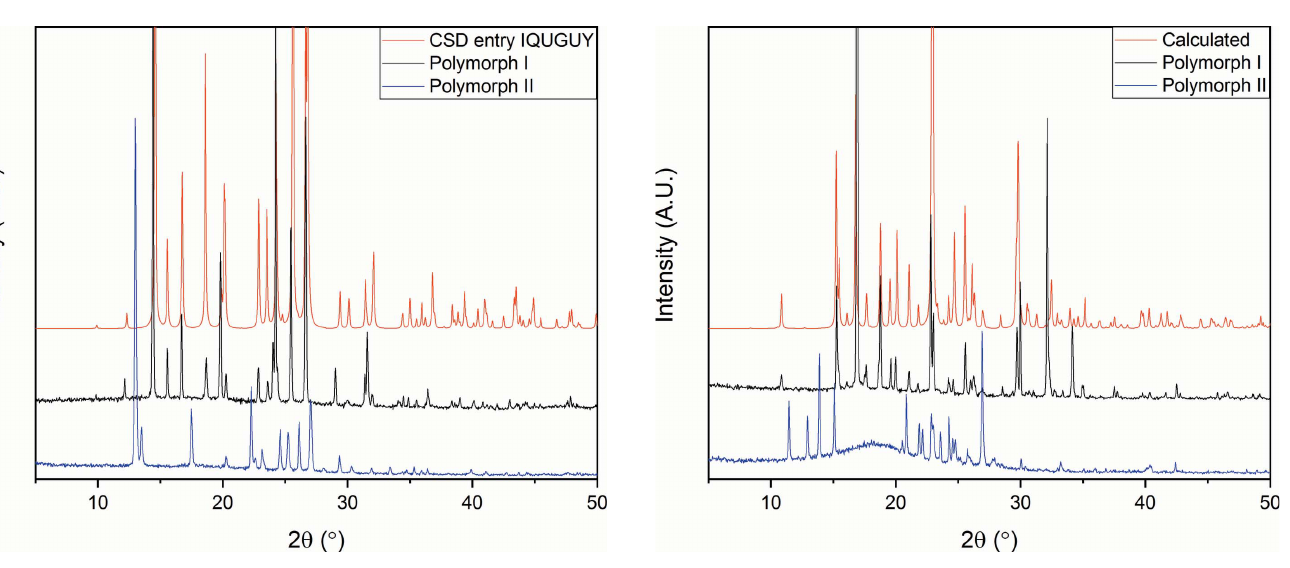
Figure 9 Powder X-ray diffraction measurements of form I (black) and II (blue) of 3,5-DMBz. The powder pattern (red) was calculated from the crystal structure.